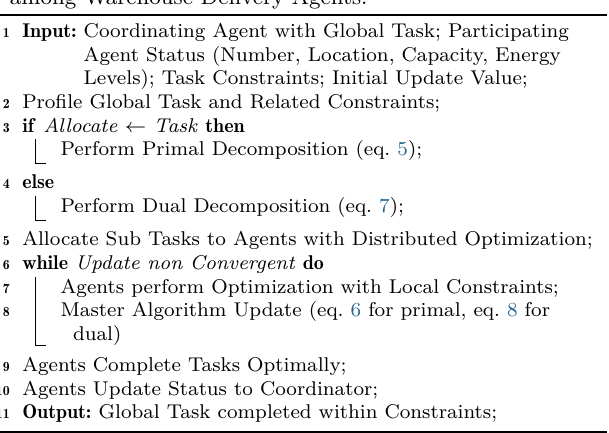
Algorithm 1: Distributed Optimal Task